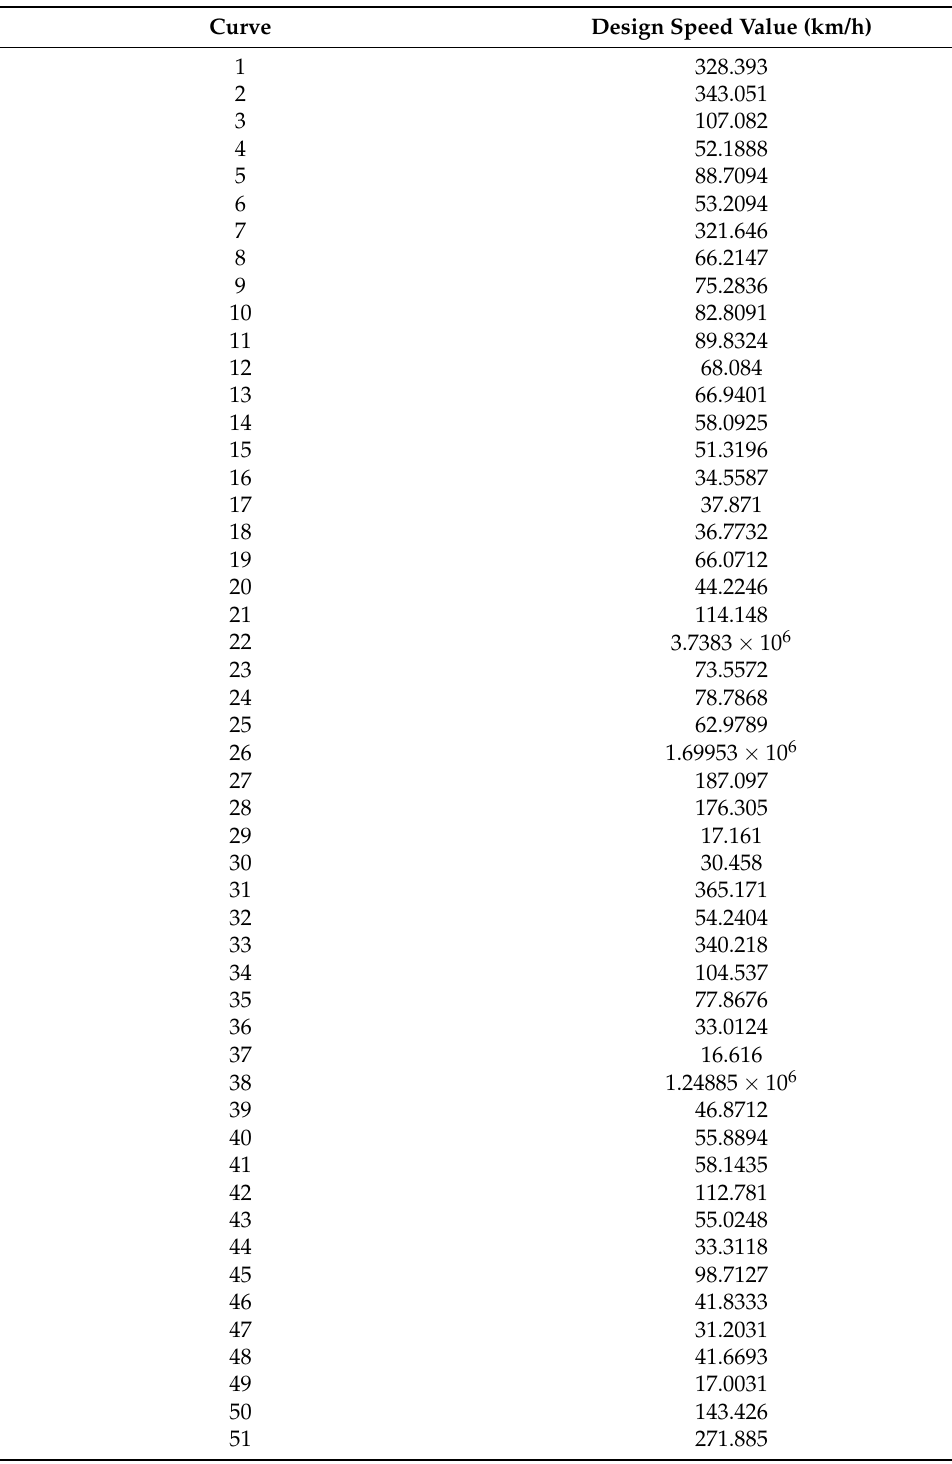
Table A4. Design Speed Value.